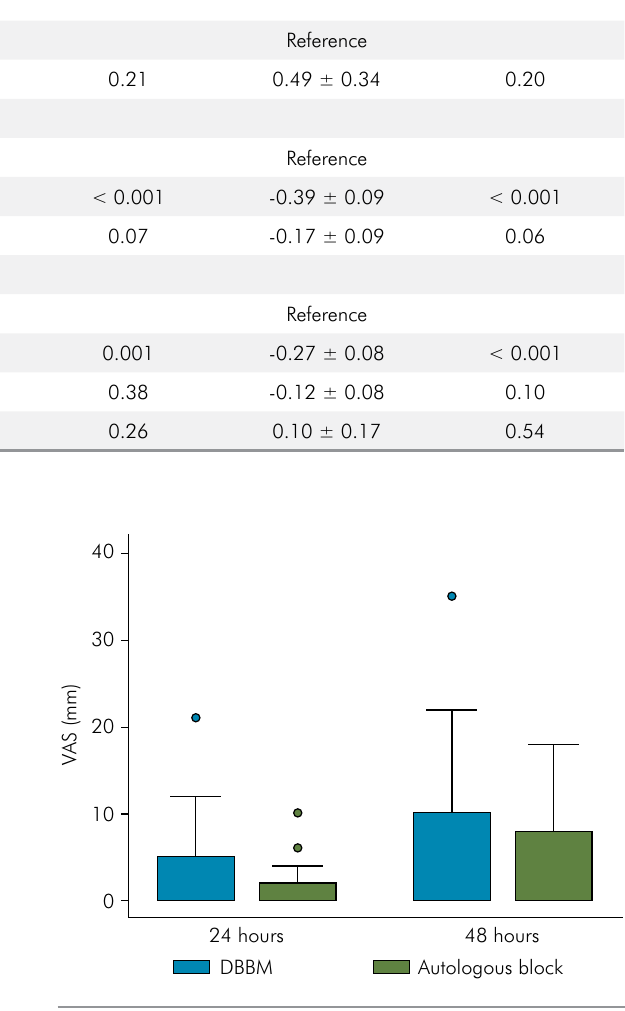
Figure 3. Boxplot of VAS scores for the two groups after 24 and 48 hours of the surgery.